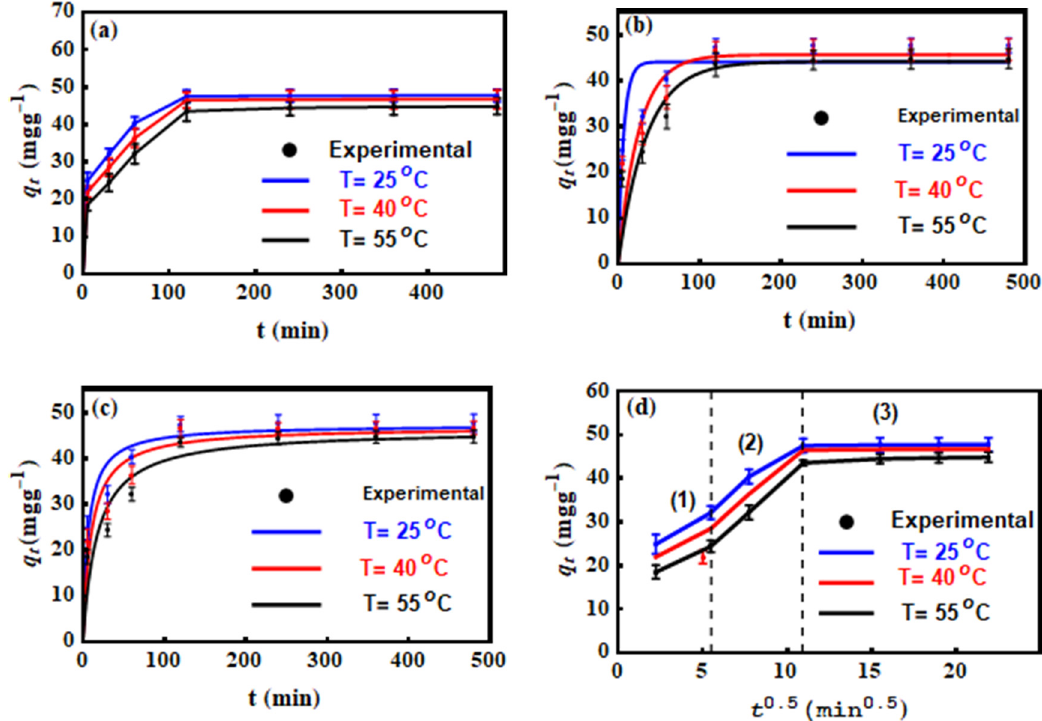
Figure 3. Kinetic studies of MO uptake by the Mn-mica, effect of contact time ( a ), pseudo-first order model ( b ), pseudo-second order model ( c ) and intra-particle diffusion model ( d ) at different temperatures. Table 4. Parameters of kinetic models for the adsorption of MO on adsorbent